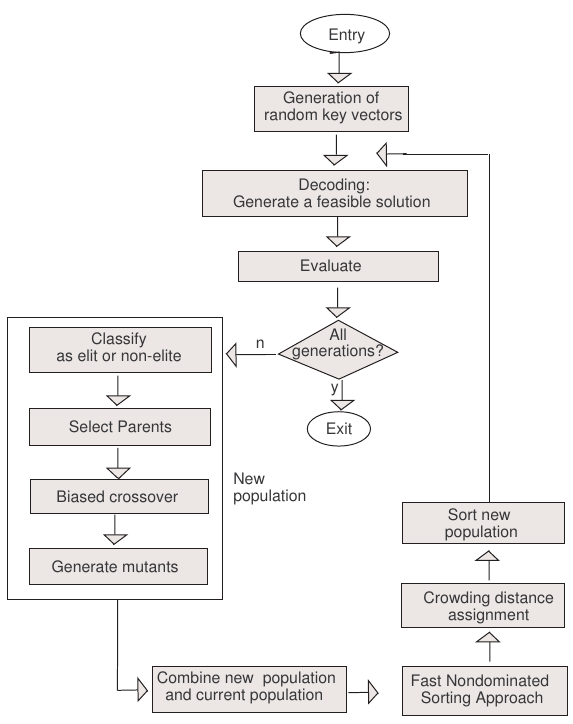
Figure 1. Flowchart of BRKGA multi-objective